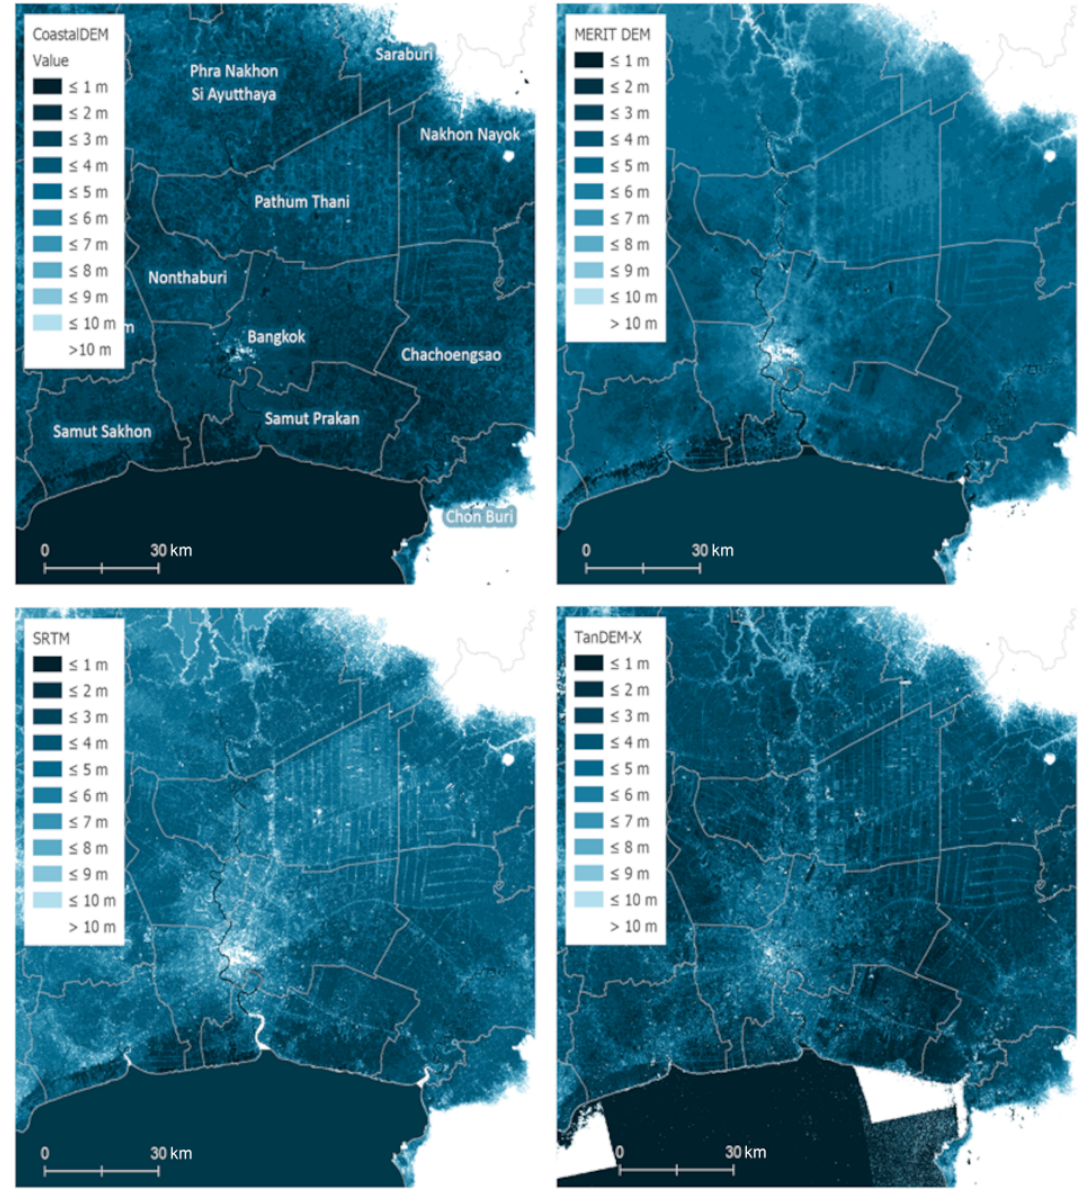
Figure 1. Elevation source data for constructing low-elevation coastal zones (LECZs), Bangkok and surrounding areas, Thailand. Note that the darkest blue indicates ocean, and gray boundaries indicate first-order administrative